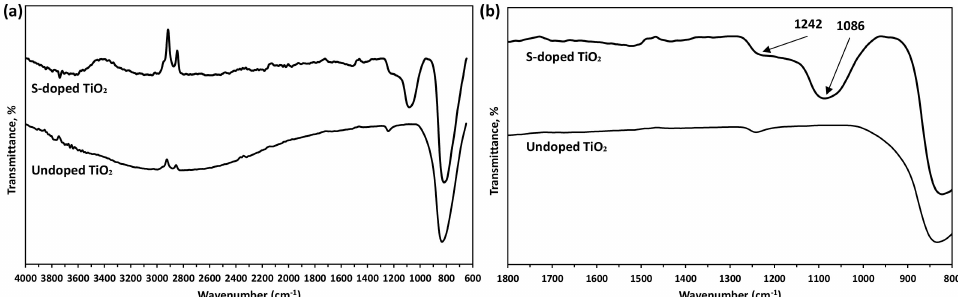
Figure 3. ( a ) FTIR spectrum and ( b ) sulfur characteristic absorption peaks of undoped and S-doped TiO 2 ETL sintered at 450 ◦